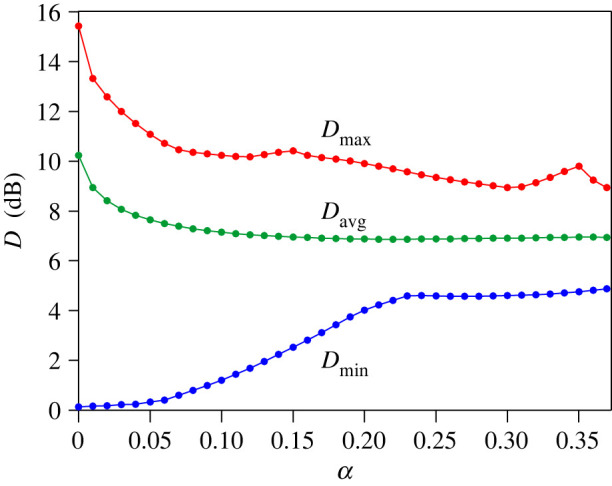
Changes in Dmax, Dmin and Davg with the absorption coefficient α. Coloured dots indicate calculation results.